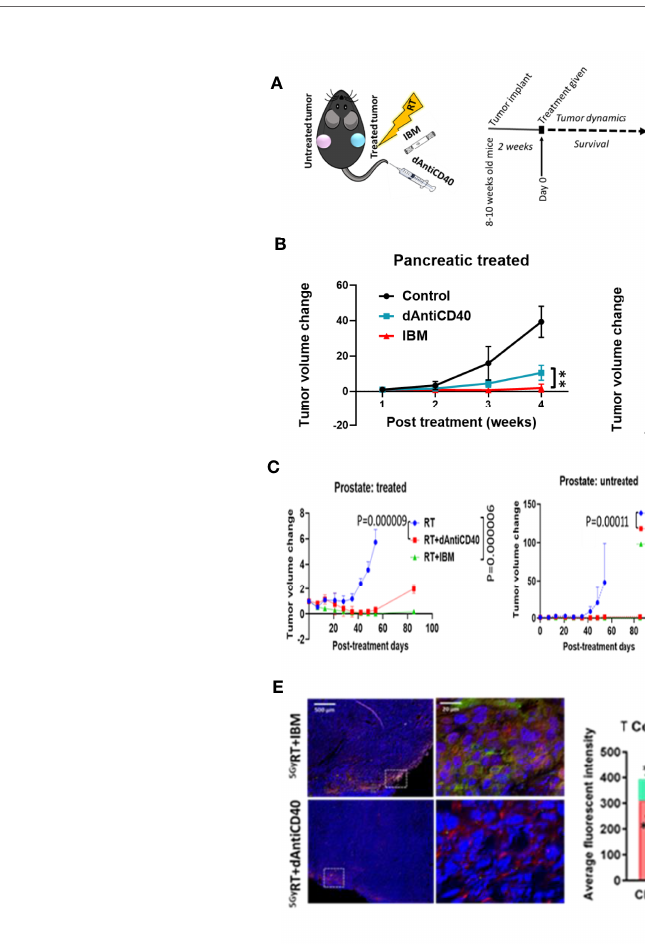
( Figure 4E ). For a more precise comparison, survival rates were adjusted to the initial pretreatment tumor size. The adjusted hazard ratios (HR) for each treatment group compared with control can be found in Table 1 . For all tested treatment regimens, the chance to reach one of the previously stated endpoints was signi fi cantly lower than for the control group (HR <1, Bonferroni adjusted p -value <0.05), hence again all tested treatments were shown to prolong the survival period.